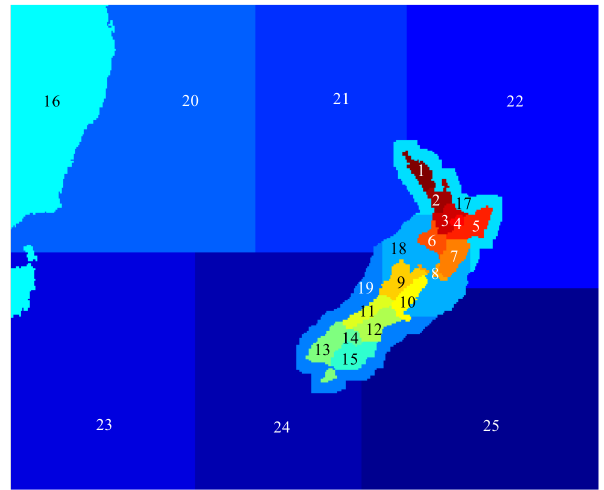
Figure 8. Regional partitioning and indices in the inversion.